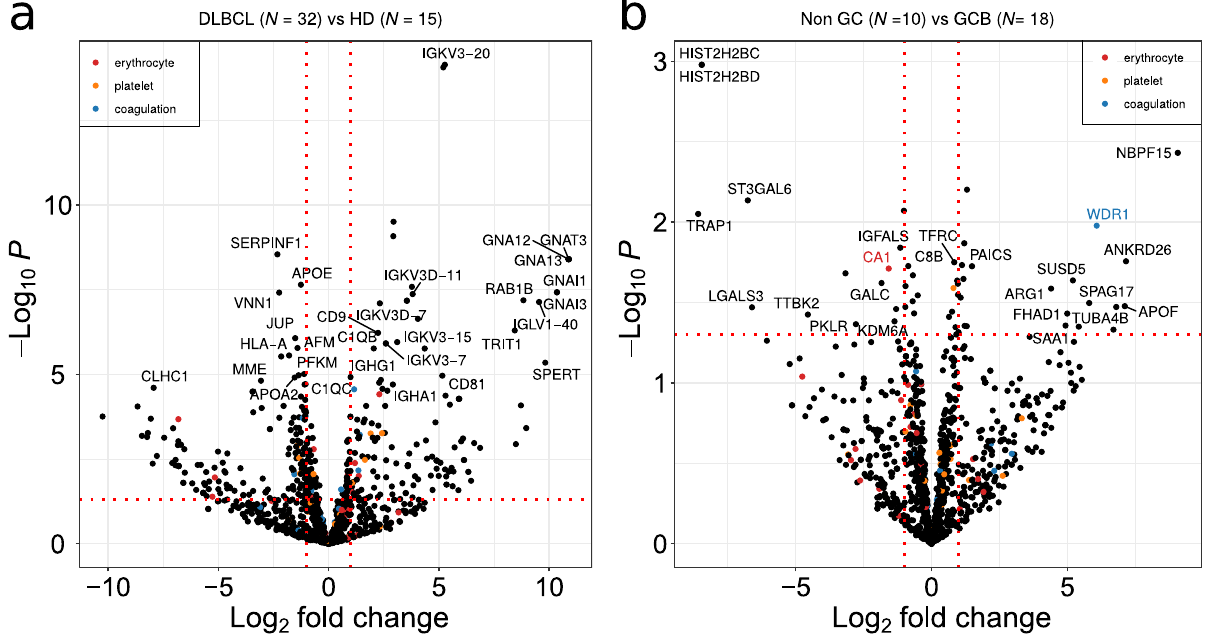
Figure 5. Volcano plot depicting deregulated proteins when comparing ( a ) DLBCL versus HD and ( b ) non-GCB versus GCB. A p -value threshold of 0.05 is indicated by a horizontal red dotted line. The log 2 fold up or down regulation is represented by the red vertical line. Potential contaminants from erythrocyte, platelet and coagulation are indicated by red, orange and blue dots, respective ‐ ly.